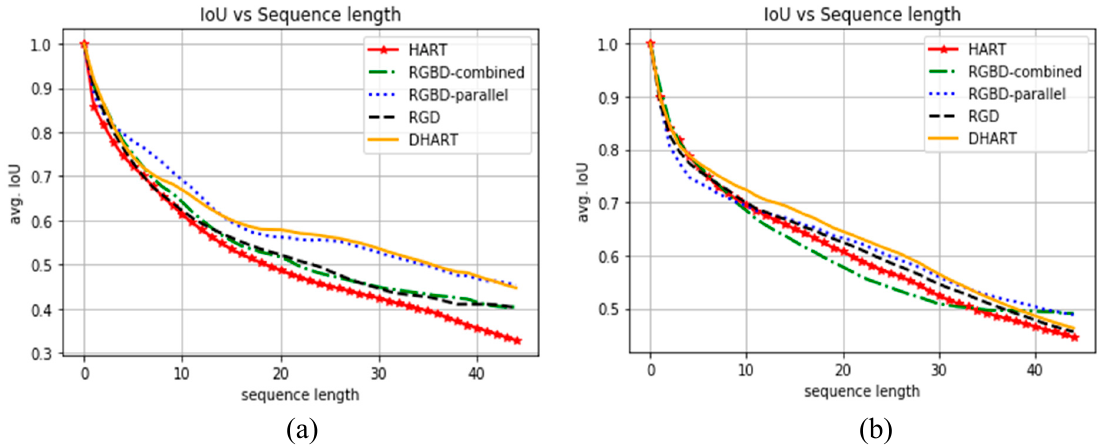
Figure 8. IoU curves on frames over 48 timesteps (higher is better). ( a ) Results for images captured by Kinect V2.0 in challenging environments containing color camouflage and occlusion. ( b ) Results for the Princeton Dataset. The results show that adding depth in all three methods improves the IoU, and using just depth also has a better performance on both real-word data and the Princeton dataset.